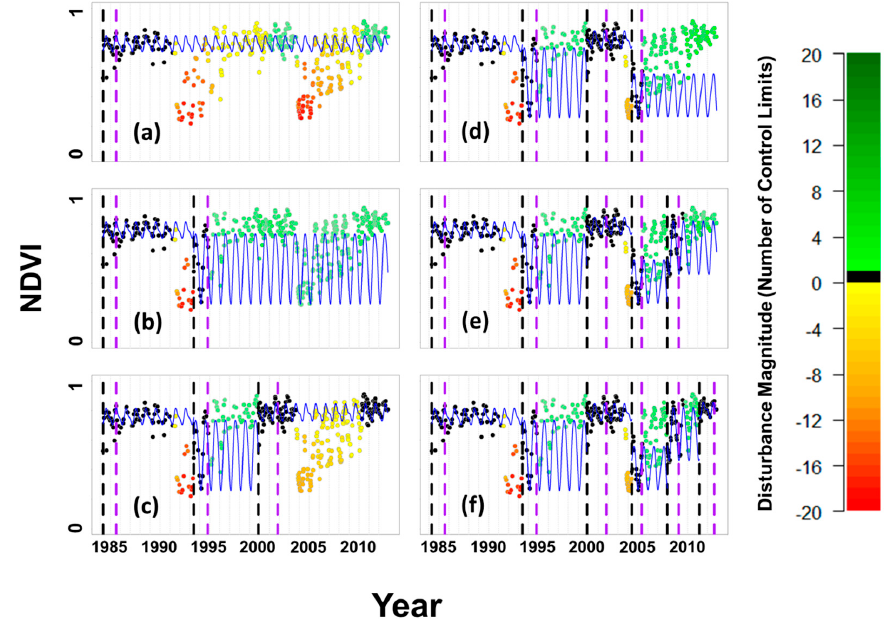
Figure 5. Edyn algorithm, step by step, using the same forested pine pixel from Figures 1 and 2. ( a ) The first pass of the algorithm is identical to a normal EWMACD run (the blue curve is the harmonic fit and the black and purple lines demarcate the beginning and end of the curve training period); ( b ) the second pass retrains the harmonic curve after the initial disturbance (in this case in 1991) is determined to have stabilized; ( c – f ) subsequent passes continue until no further signals are detected or insufficient training data remain.